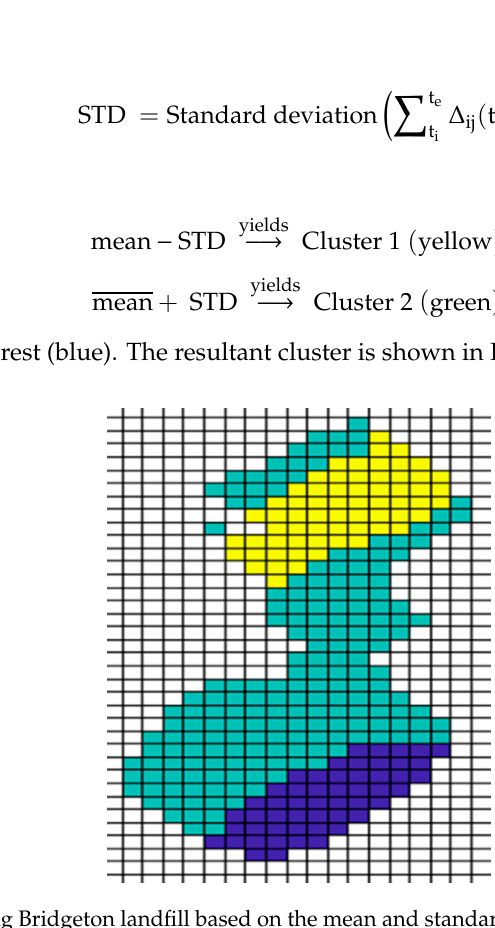
Figure A1. Clustering Bridgeton landfill based on the mean and standard deviation of all